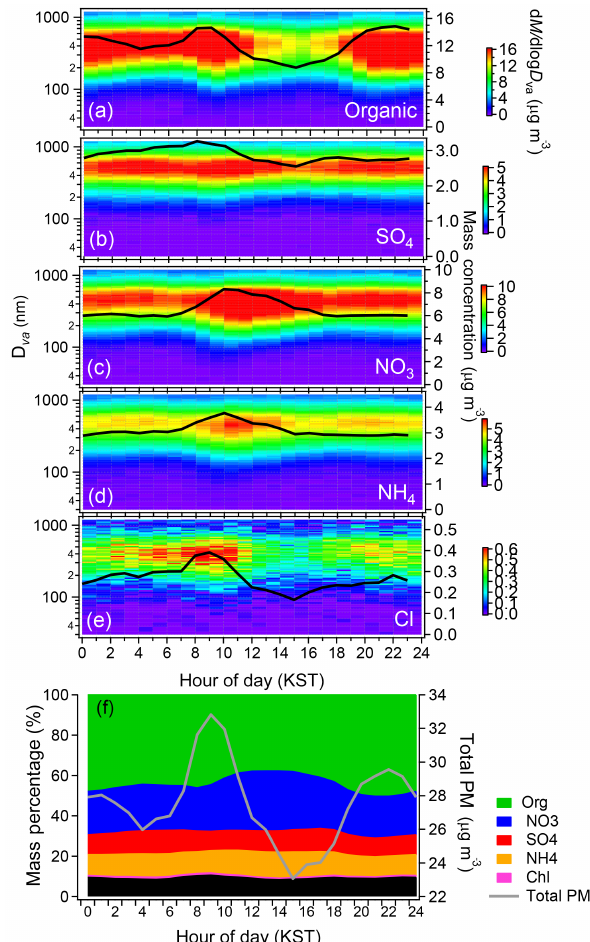
Figure 5. (a–e) Diurnal profiles, 1h averaged, of mass-based size distributions of each of the nonrefractory submicrometer particu- late matter (NR-PM 1 ) species, colored by their mass concentration (left axis, D va , vacuum aerodynamic diameter) and average diurnal profiles of each of the PM 1 species (right axis); (f) average diurnal mass fractional contribution of each PM 1 species to the total PM 1 diurnal mass and the total PM 1 mass